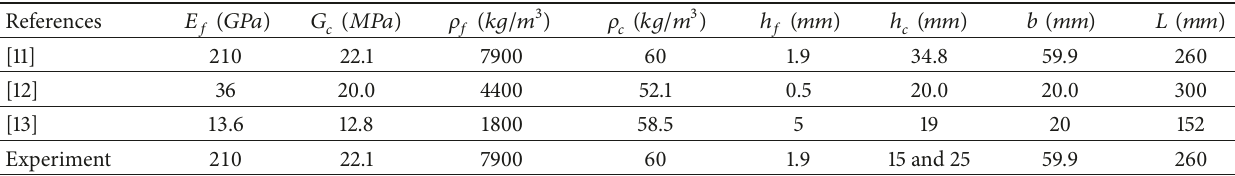
Table 1: Parameters of sandwich beam.